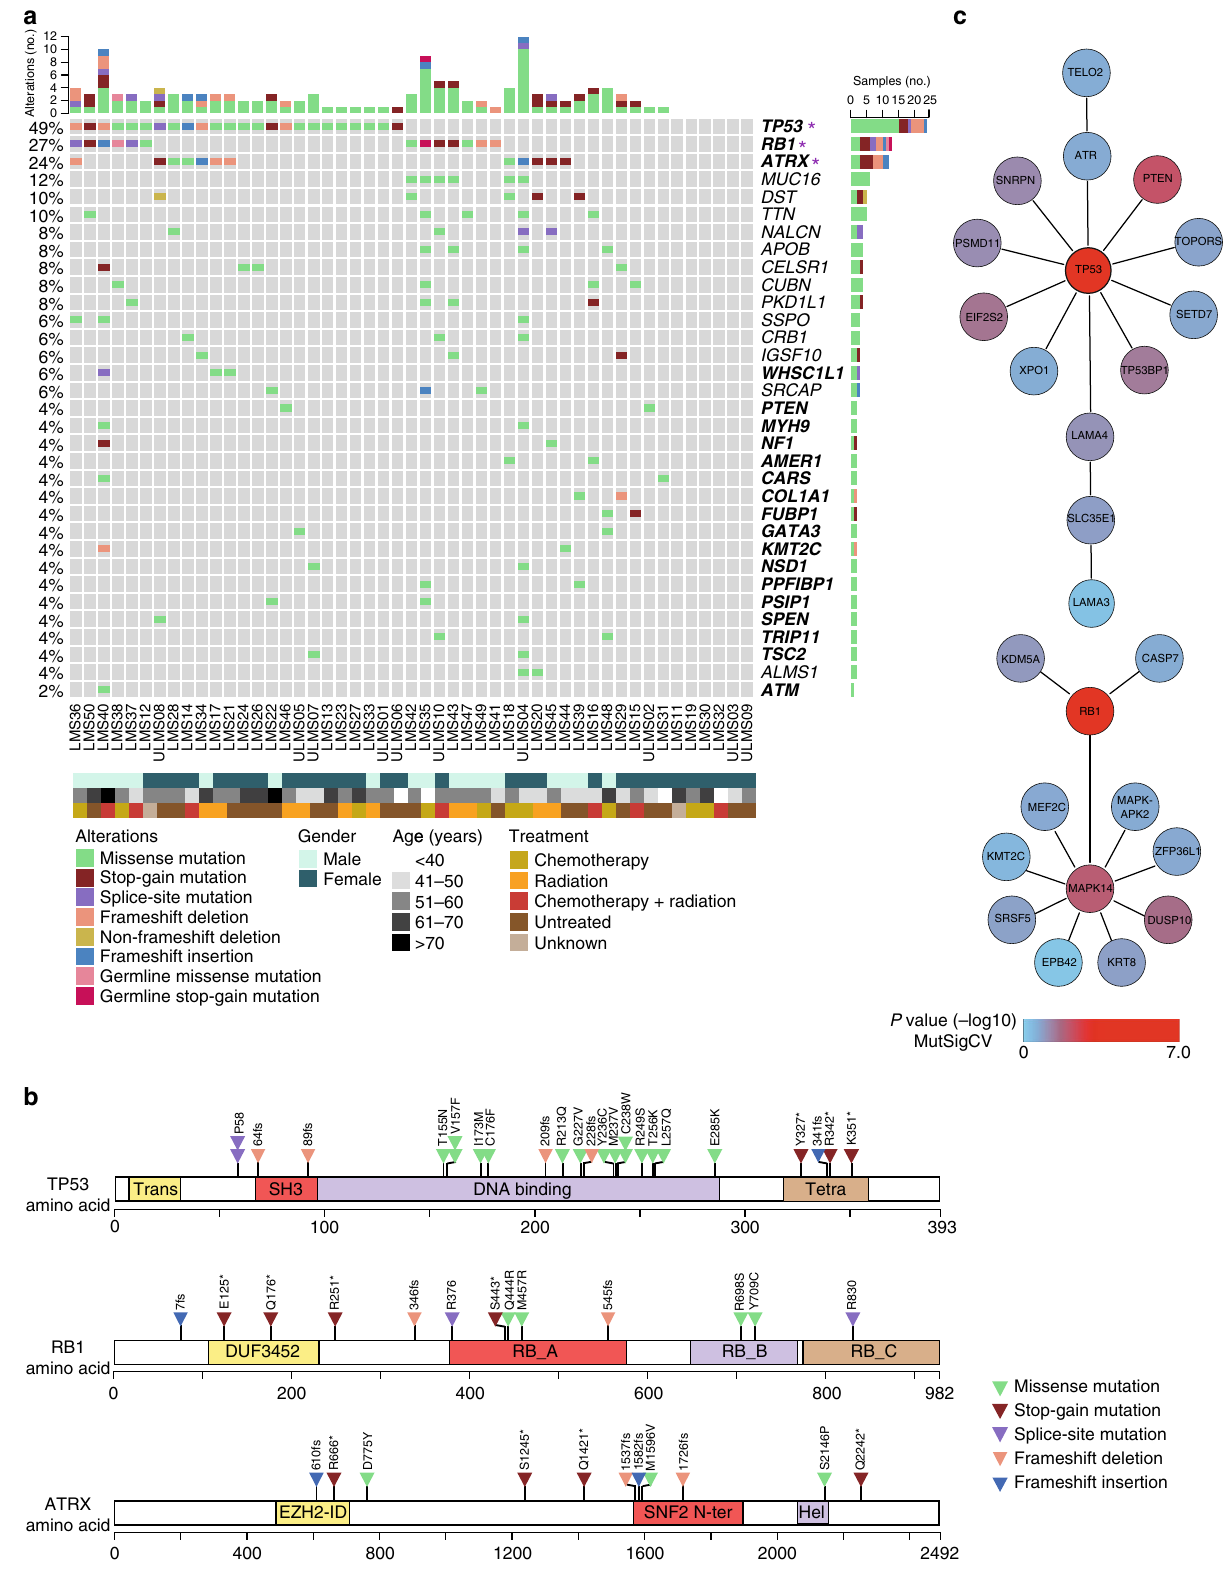
mutationMissense Stop-gain